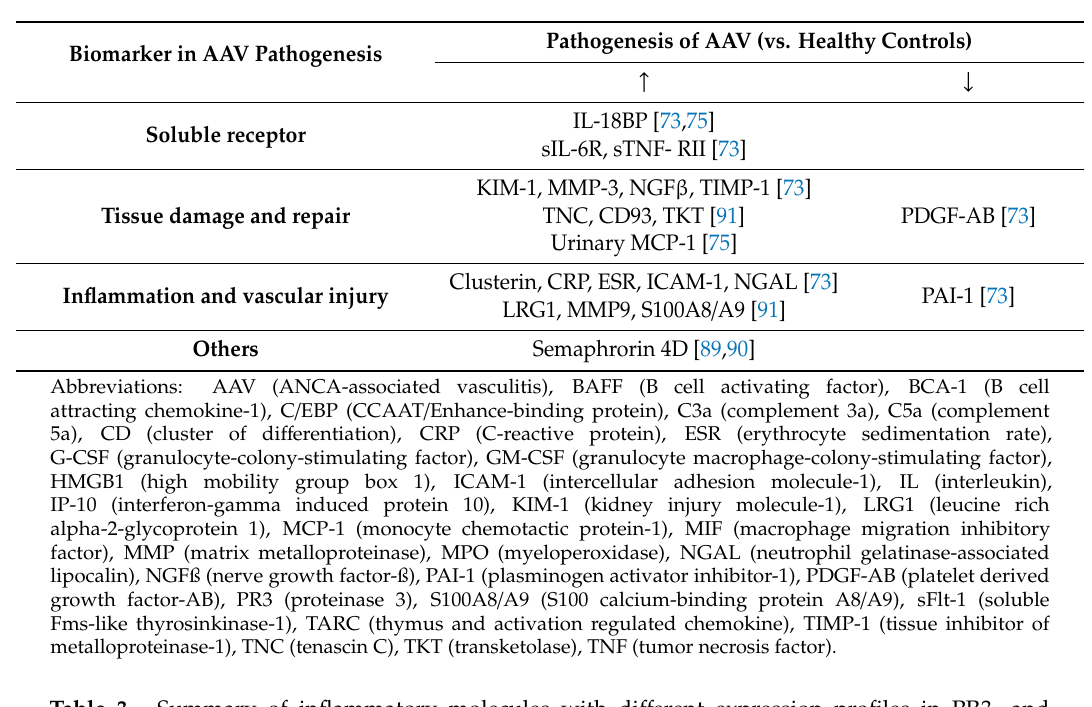
Table 3. Summary of inflammatory molecules with di ff erent expression profiles in PR3- and MPO-ANCA